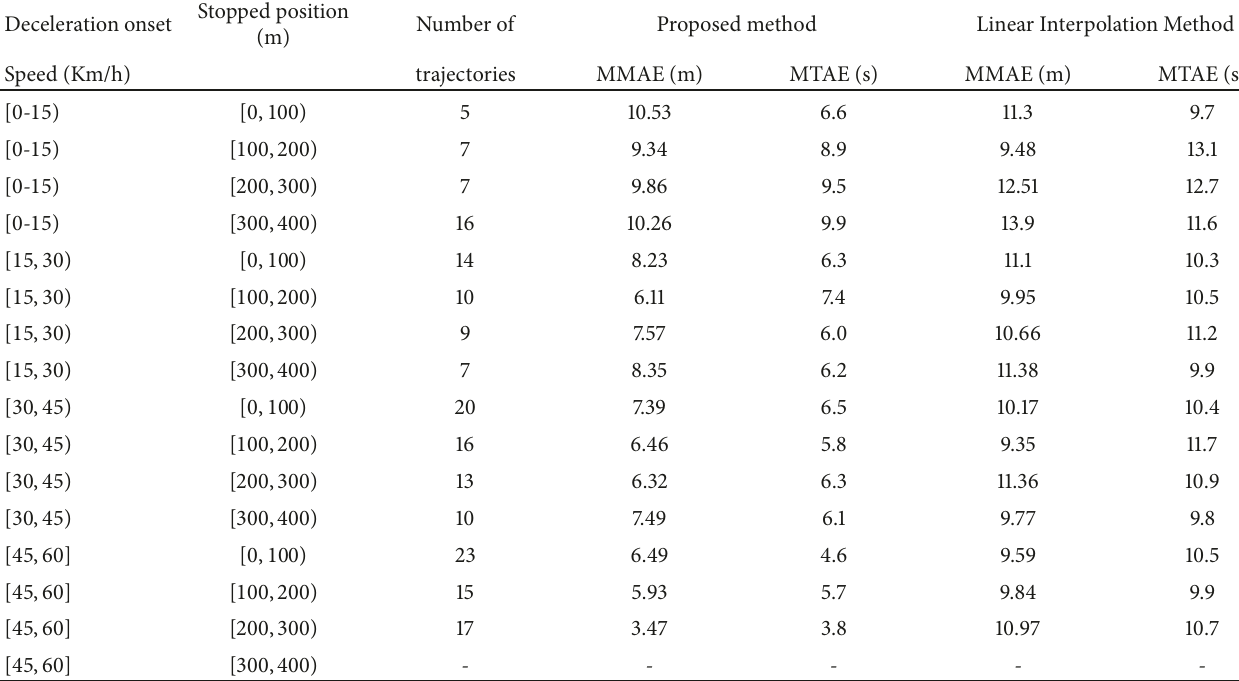
Table 2: Trajectory estimation error for proposed method and benchmark